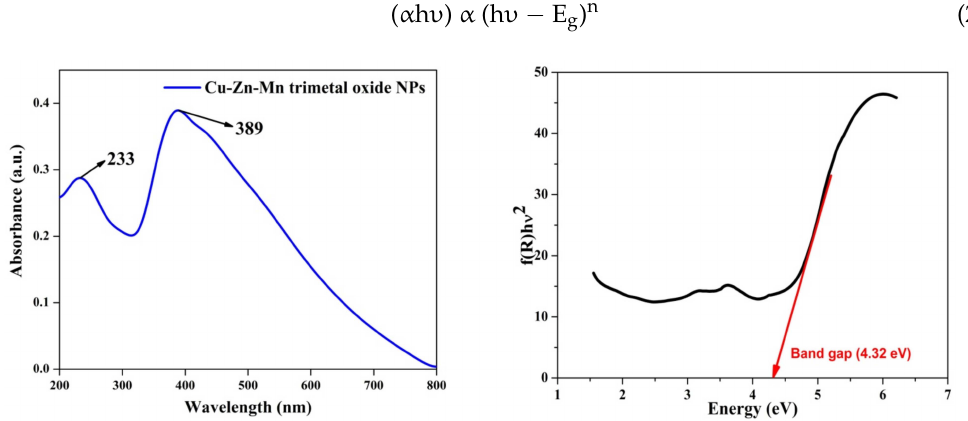
Figure 8. UV-Vis and Tauc plot of Cu-Zn-Mn mixed trimetal oxide